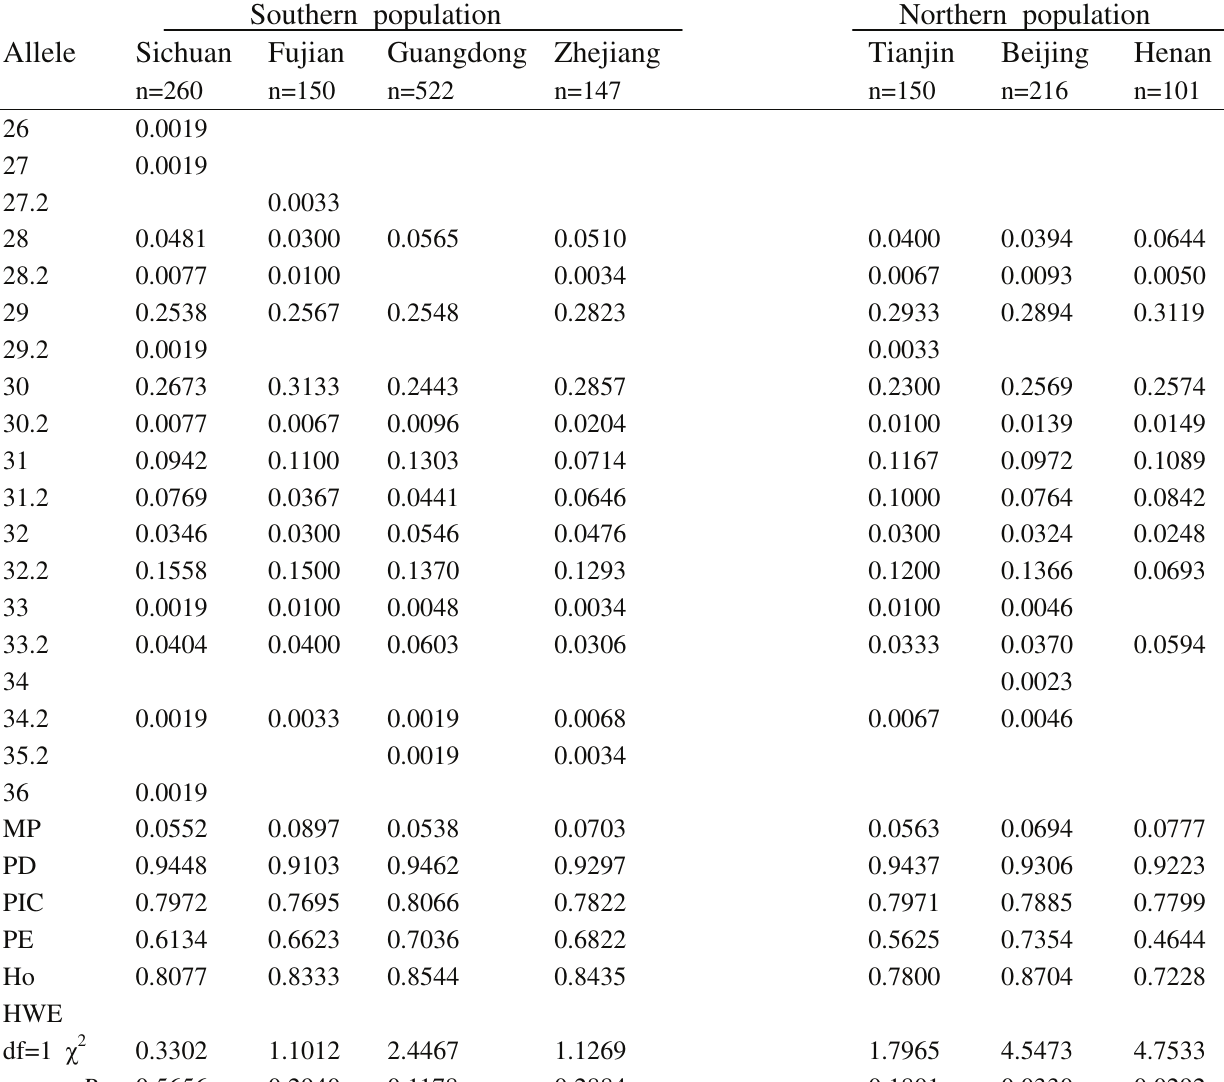
Table S10- Genetic polymorphism at the D21S11 locus for the seven Chinese population groups. Southern